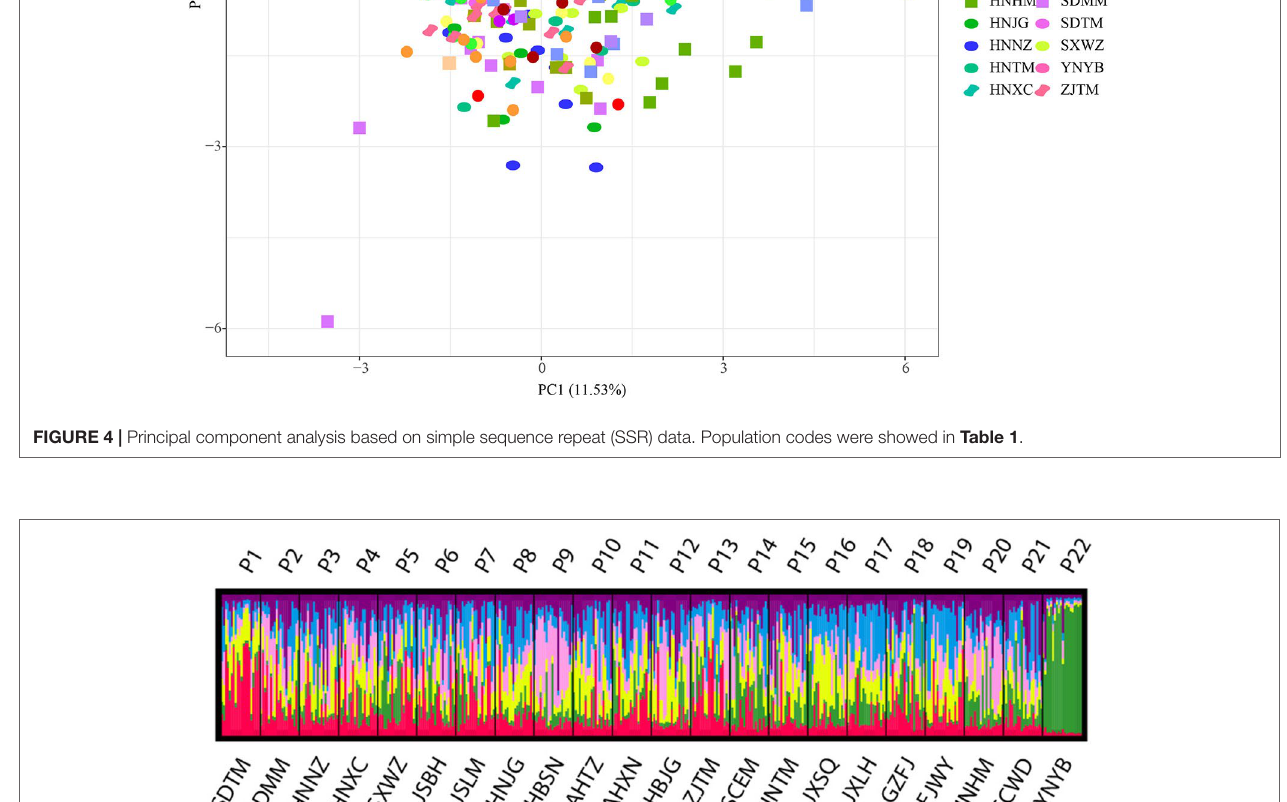
Frontiers in Genetics |